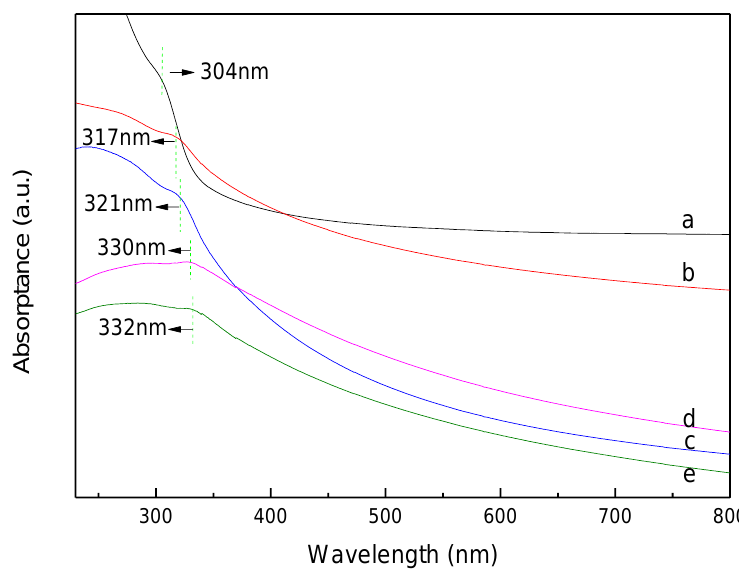
Figure 4. UV-Vis absorption spectra of ZnS ( a ), Al-ZnS ( b ), Al-ZG0.6 ( c ), Al-ZG1.2 ( d ) and Al-ZG1.8 ( e ).